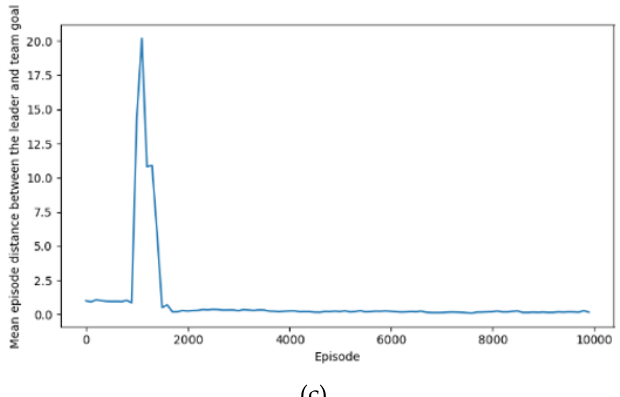
Figure 8. The mean distance between the leader and the team goal with the proposed scheme and different team sizes during formation generation policies training: ( a ) mean distance for the leader in the team of 3 USVs; ( b ) mean distance for the team of 5 USVs; ( c ) mean distance for the team of 7 USVs.